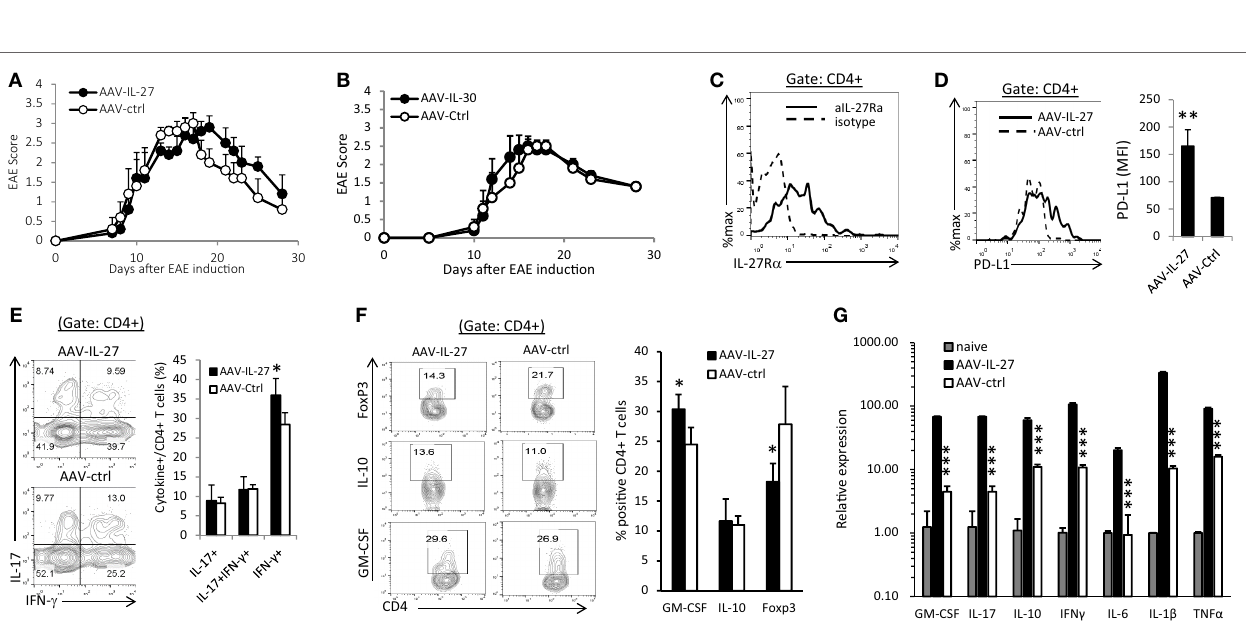
FigUre 5 | Therapeutic effect of adeno-associated viral vector (AAV)-interleukin-27 (IL-27) or AAV-IL-30 on established experimental autoimmune encephalomyelitis (EAE). C57BL6 mice were immunized with MOG peptide/CFA and pertussis toxin. Ten days after immunization, when the first symptoms of EAE appeared, mice ( n = 5/group) were treated with AAV-IL-27 (a) or AAV-IL-30 (B) virus i.m. The mice were then evaluated for the development of EAE signs. EAE scores are expressed as means ± SD. Data shown represent three experiments with similar results. On day 29 after EAE induction, the mice were sacrificed and the expression of IL-27R α (c) , PD-L1 (D) , IFN- γ /IL-17A (e) , and FoxP3/IL-10/GM-CSF (F) in the central nervous system-infiltrating CD4 + T cells were analyzed by flow cytometry. Data shown represent two to three experiments with similar results. Statistical analysis was performed using the unpaired Student’s t -test. * P < 0.05; ** P < 0.01.